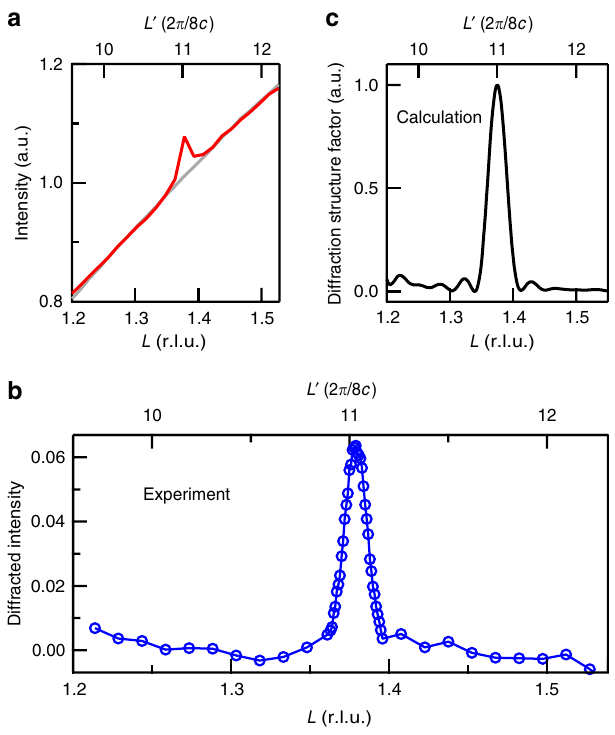
Figure 2 | Out-of-plane component of the electronic supermodulation. ( a ) Scattered intensity line cuts along L measured on sample #1 at 50K and 930.6eV at fixed H ¼ (cid:2) 0.245 and K ¼ 0. Average intensity in the peak region and background region of the CCD image are shown in red and grey curves, respectively. ( b ) Diffracted intensity for the same line cut, which is the difference between red and grey curves in a . The diffracted intensity in b shares the same scale with the intensity in a . ( c ) Calculated diffraction structure factor for one representative type of charge density modulation along the c axis. r.l.u., reciprocal lattice